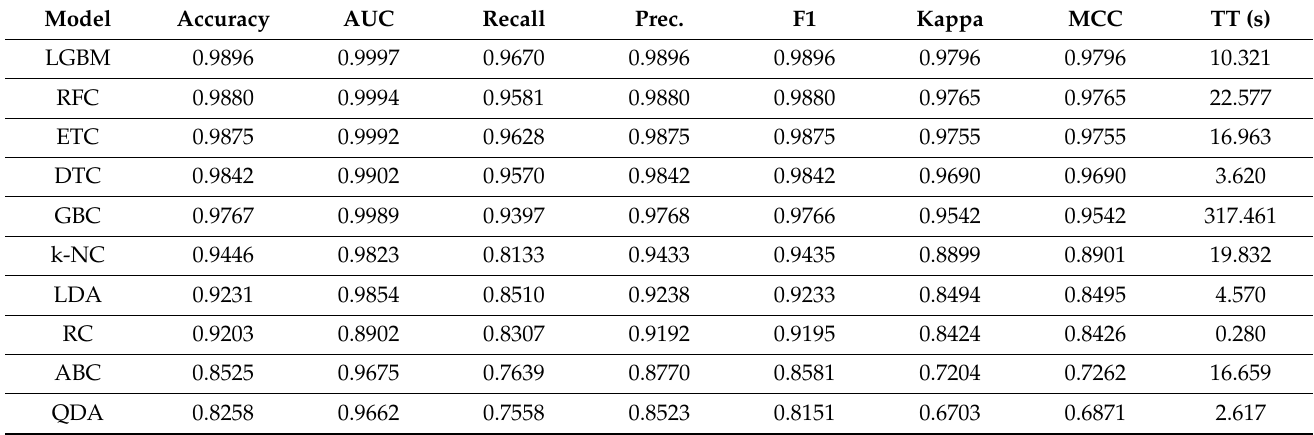
Figure 6. IPFIXcol with CICFlowMeter plugin. Table 1. Performance metrics of the ANTA method (model selection